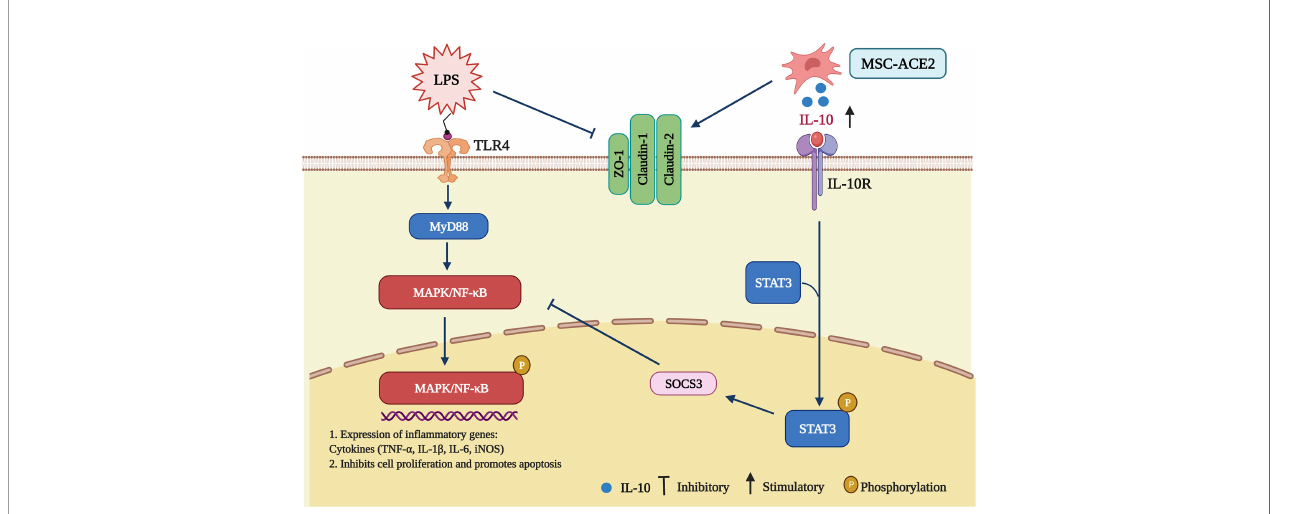
FIGURE 9 | Schematic representation of MSCs overexpressing ACE2 favorably ameliorate LPS-induced in fl ammatory injury in mammary epithelial cells (Charting with BioRender.com software). 1 µg/mL of LPS concentration treated with EpH4-Ev for 9 h caused signi fi cant cell injury, activated MAPK/NF- k B signaling pathway, promoted the release of in fl ammatory factors TNF- a , IL-I b , IL-6, iNOS, inhibited cell proliferation, promoted apoptosis, disrupted blood-milk barrier and aggravated mammary epithelial cells injury. Co-culture with MSC, MSC-GFP or MSC-ACE2 reversed LPS-induced mammary epithelial cells injury, inhibited MAPK/NF- k B signaling pathway, activated IL-10/STAT3/SOCS3 signaling pathway, promoted cells proliferation, inhibited apoptosis, promoted tight junction protein expression and promoted blood-milk barrier repair, and MSC-ACE2 showed better anti-in fl ammatory and anti-injury effects than MSC and